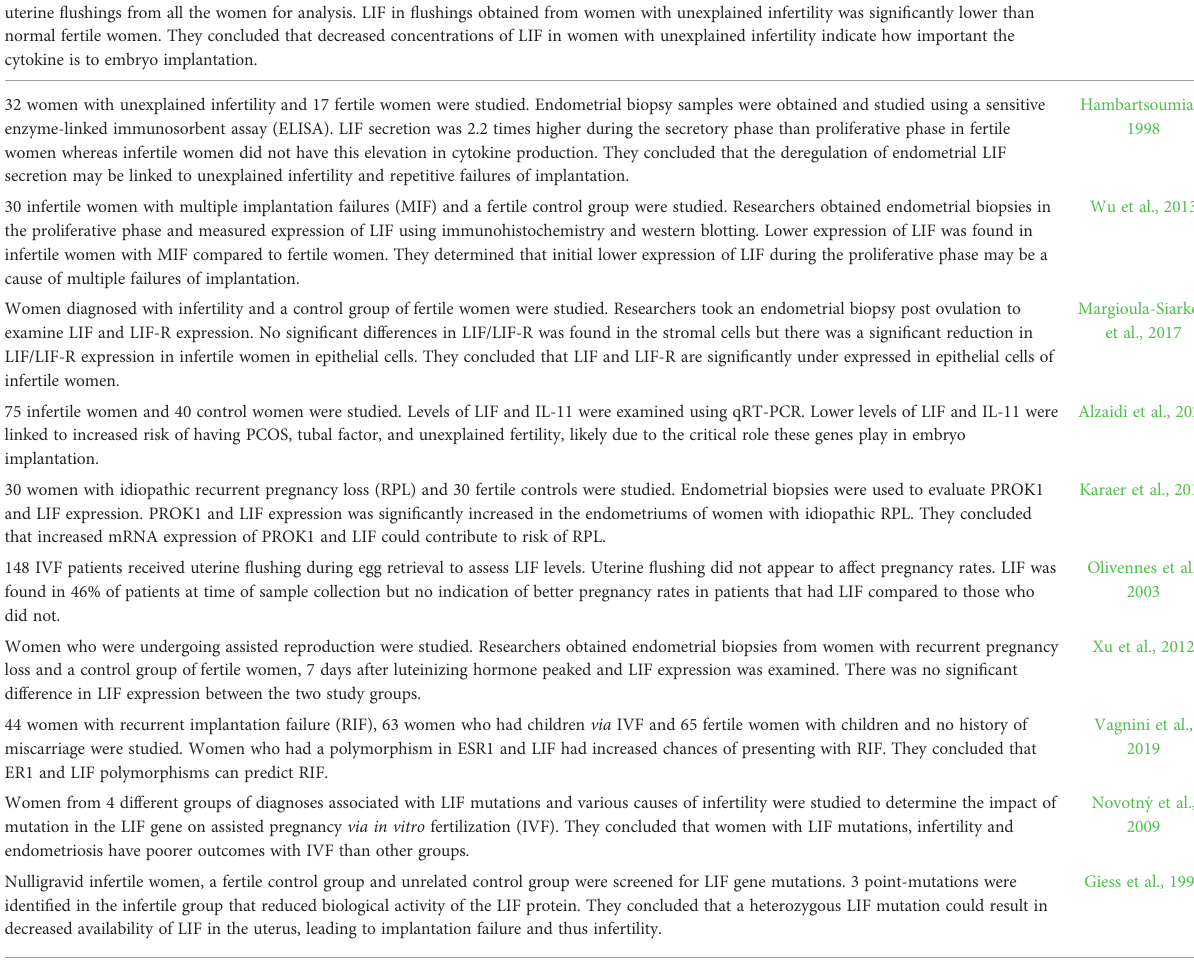
TABLE 2 In fl uence of LIF in human infertility, miscarriage and assisted pregnancy Brief description of the study. Normal fertile women, women with unexplained infertility and women who suffered recurrent miscarriages were studied. Researchers obtained uterine fl ushings from all the women for analysis. LIF in fl ushings obtained from women with unexplained infertility was signi fi cantly lower than normal fertile women. They concluded that decreased concentrations of LIF in women with unexplained infertility indicate how important the cytokine is to embryo